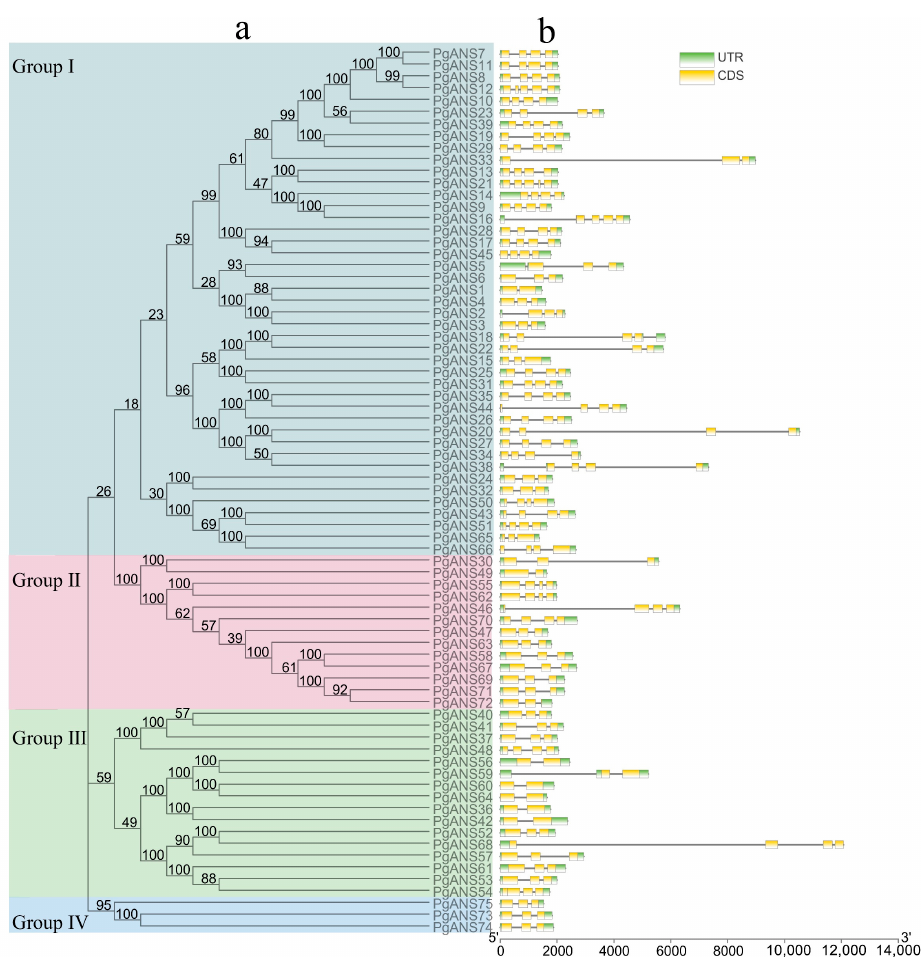
Figure 1. ( a ) Phylogenetic tree of the pomegranate ANS proteins and ( b ) genetic structure of the pomegranate ANS genes. UTR represents untranslated region, while CDS represents coding se- quence.